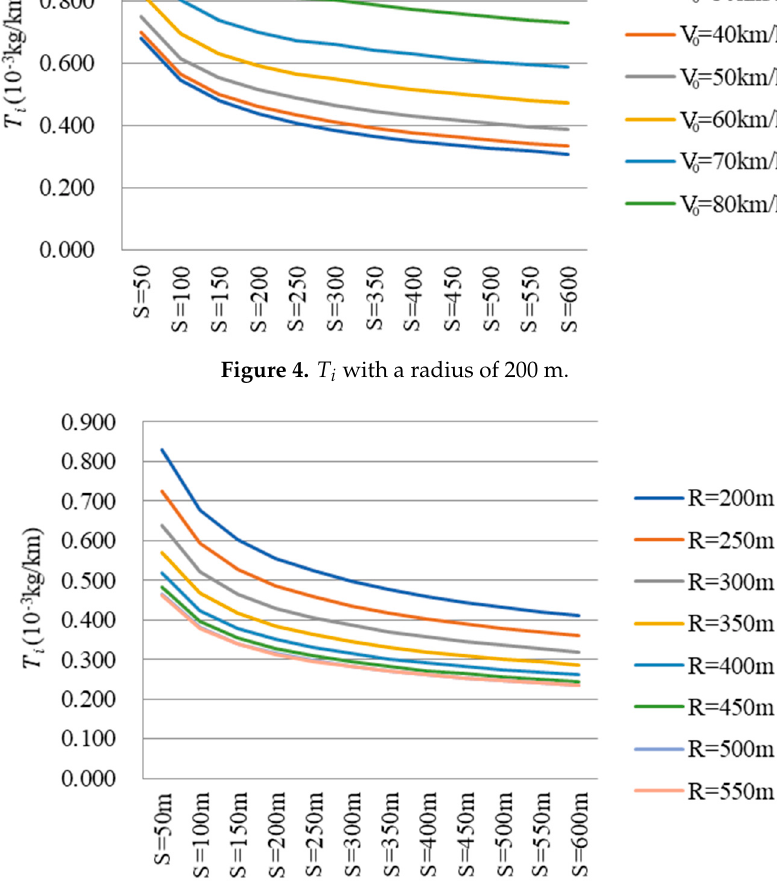
Figure 5. T i with an initial speed of 40 km / h. Figure 5. 𝑇 (cid:3036) with an initial speed of 40 km/h.